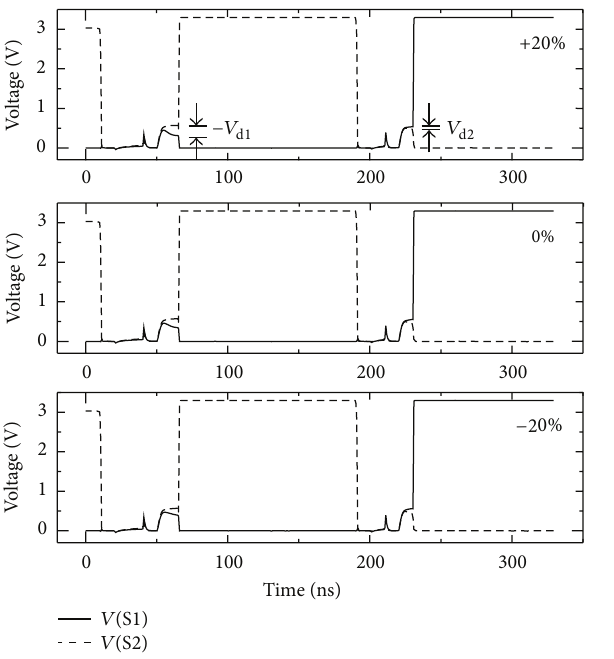
Figure 11: Effect of the channel width of the transistor on recall. Width of the channel of transistor M2 in Figure 3(b) varied from − 20% to +20%. 𝑅 , 𝑅 , and 𝑅 𝑚 were fixed at 100, 65, and 50k Ω , refa refb respectively.